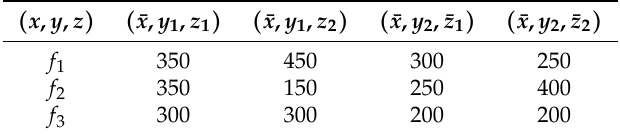
Table 1. Top-level, middle-level and bottom-level objective function values of Example